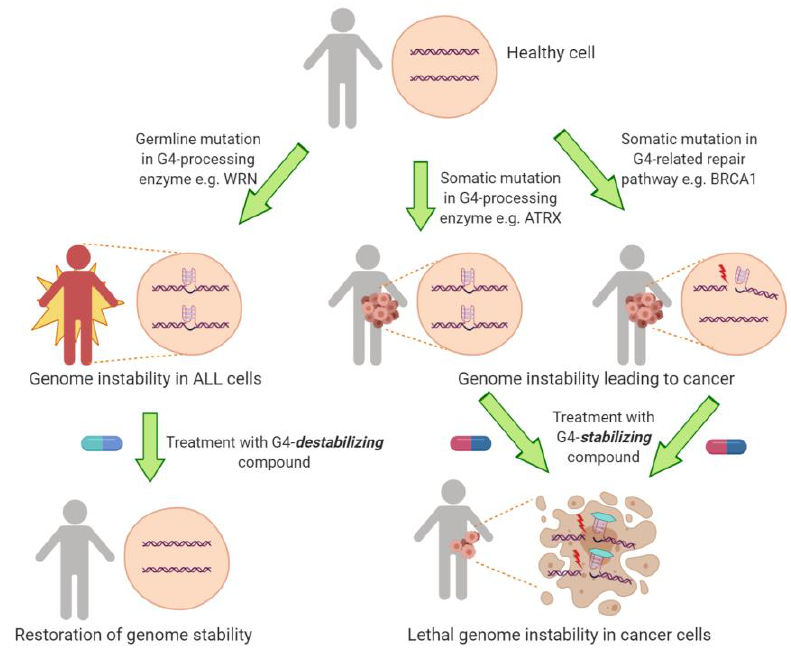
Figure 4. Potential therapeutic applications of G4 effects on the genome. Germline mutations in G4 helicases such as WRN or BLM lead to genomic instability throughout the body, which could be counteracted with G4-destabilizing compounds. Cancer-associated mutations in pathways that deal with G4 could form the basis of synthetic lethal approaches to cancer treatment. Figure created with BioRender.com.